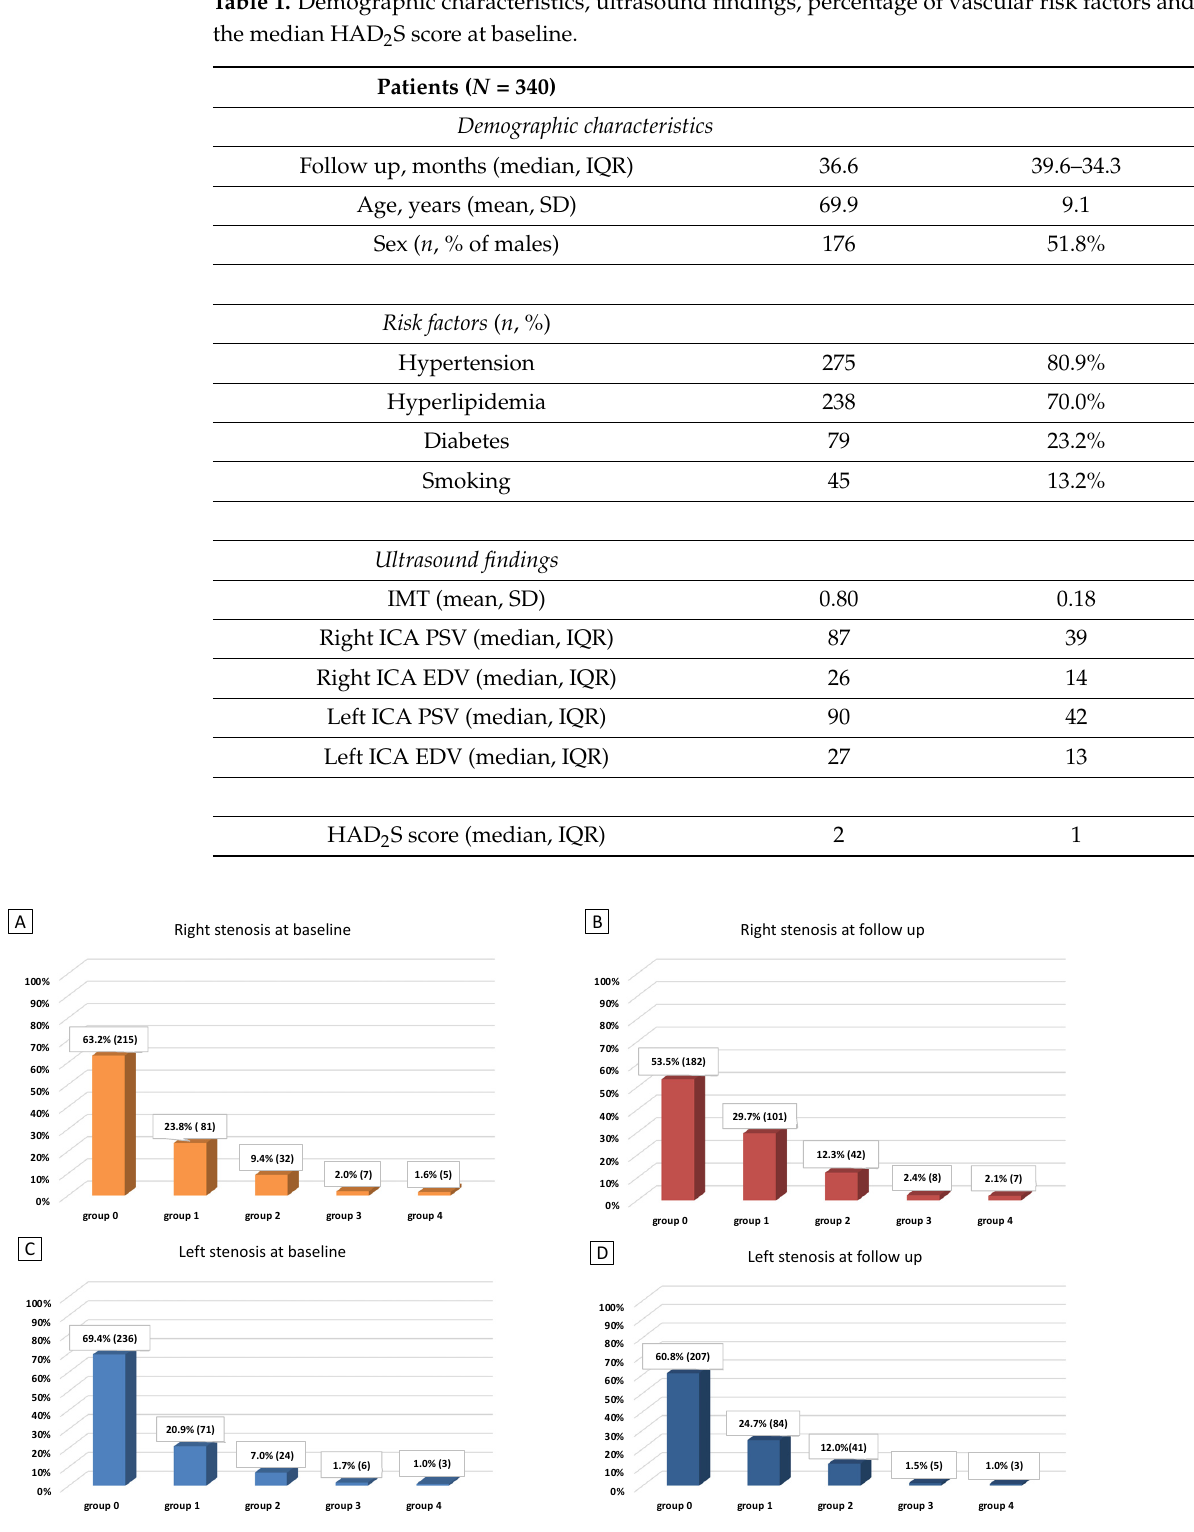
Figure 1. Groups of patients distinguished by right or left carotid stenosis score at baseline (T0) or follow up (T3). ( A ) Groups of patients distinguished by right carotid stenosis score at T0, ( B ) groups of patients distinguished by right carotid stenosis score at T3, ( C ) groups of patients distinguished by left carotid stenosis score at T0, ( D ) groups of patients distinguished by left carotid stenosis score at T3.